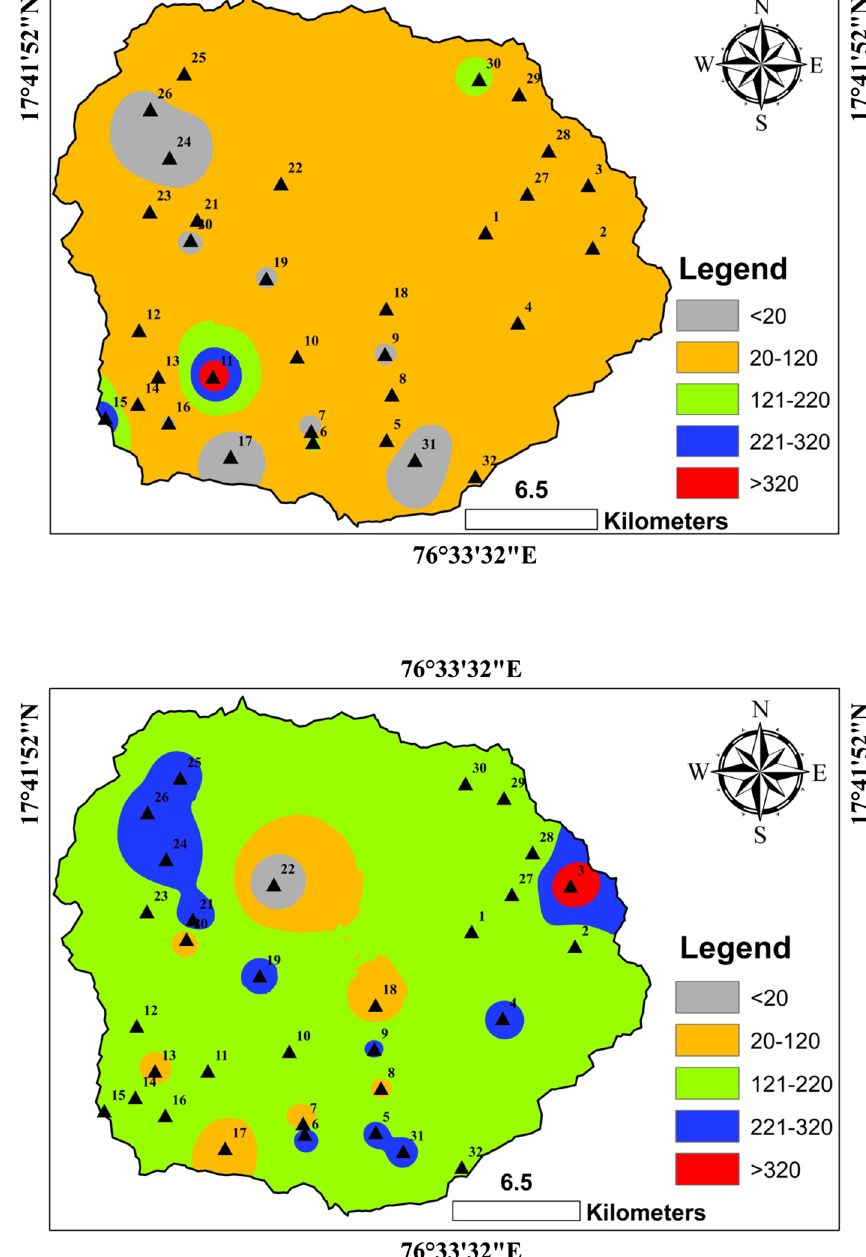
Fig. 20 Geospatial distribution of bicarbonate (pre-monsoon)